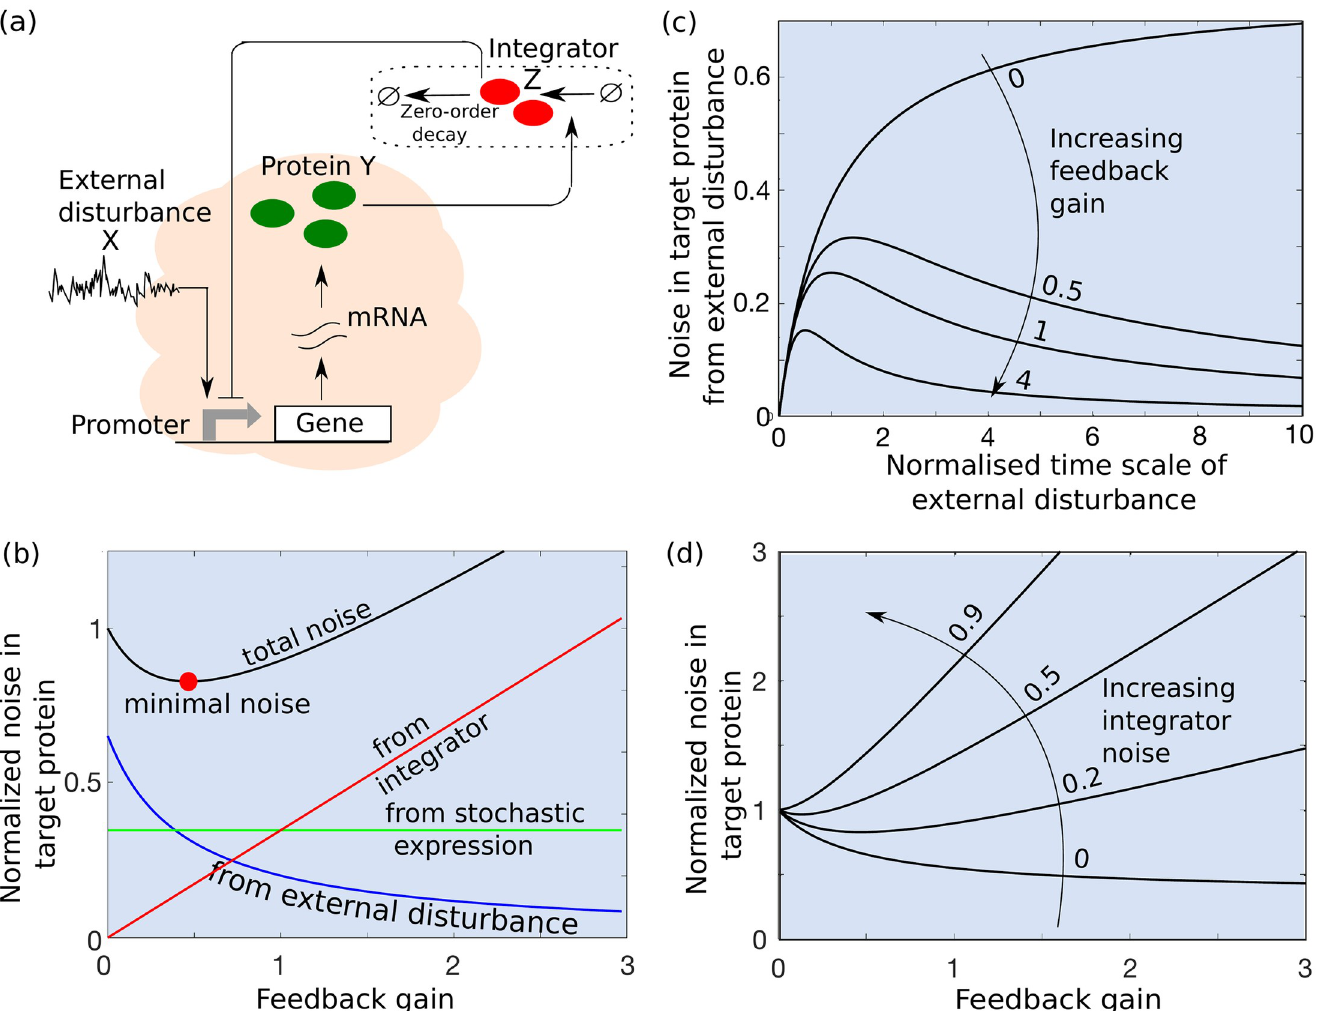
Fig 3. Implementation and noise decomposition for an integral feedback controller. (a) Design of an integral controller where the target protein Y activates an integrator species Z , Z degrades via a zero-order decay process (36) and inhibits the expression of Y . (b) Total noise in the target protein (42), and its different noise components as a function of the integral feedback gain. Integral feedback suppresses the noise contribution from external disturbance while keeping the intrinsic noise intact to its open-loop value. The noise contribution from the integrator increases with feedback gain and the total noise is minimized at an intermediate feedback gain. All noise levels are normalized to the total noise at f i = 0. c) The external noise contribution in (42) varies non-monotonically as a function of the normalized time-scale of disturbance fluctuations γ / γ for different feedback gains. Other parameters taken as CV 2 ¼ 0 : 5 , k = γ , h z i = h y i ¼ 1 . (d) The total normalized noise in y x z y X . For this plot parameters taken as CV 2 ¼ 0 : 5 , γ = 3 γ and CV 2 ¼ 0 : 2 Y with respect to the feedback gain for different integrator noise CV 2 y x Z X int